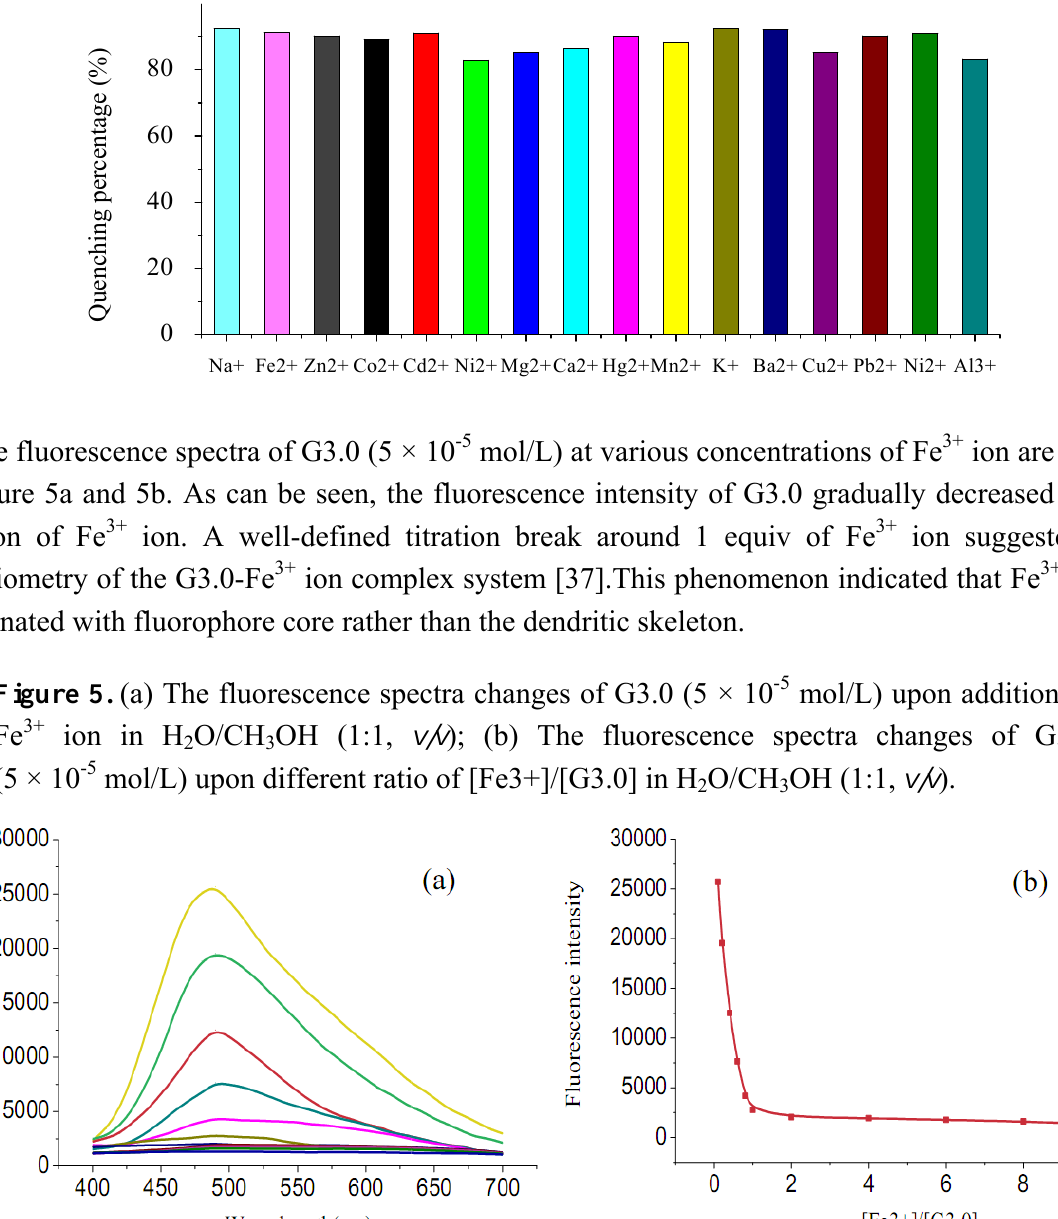
-I)/I ] × 100% of G3.0 (5 × 10 -5 mol/L) 0 0